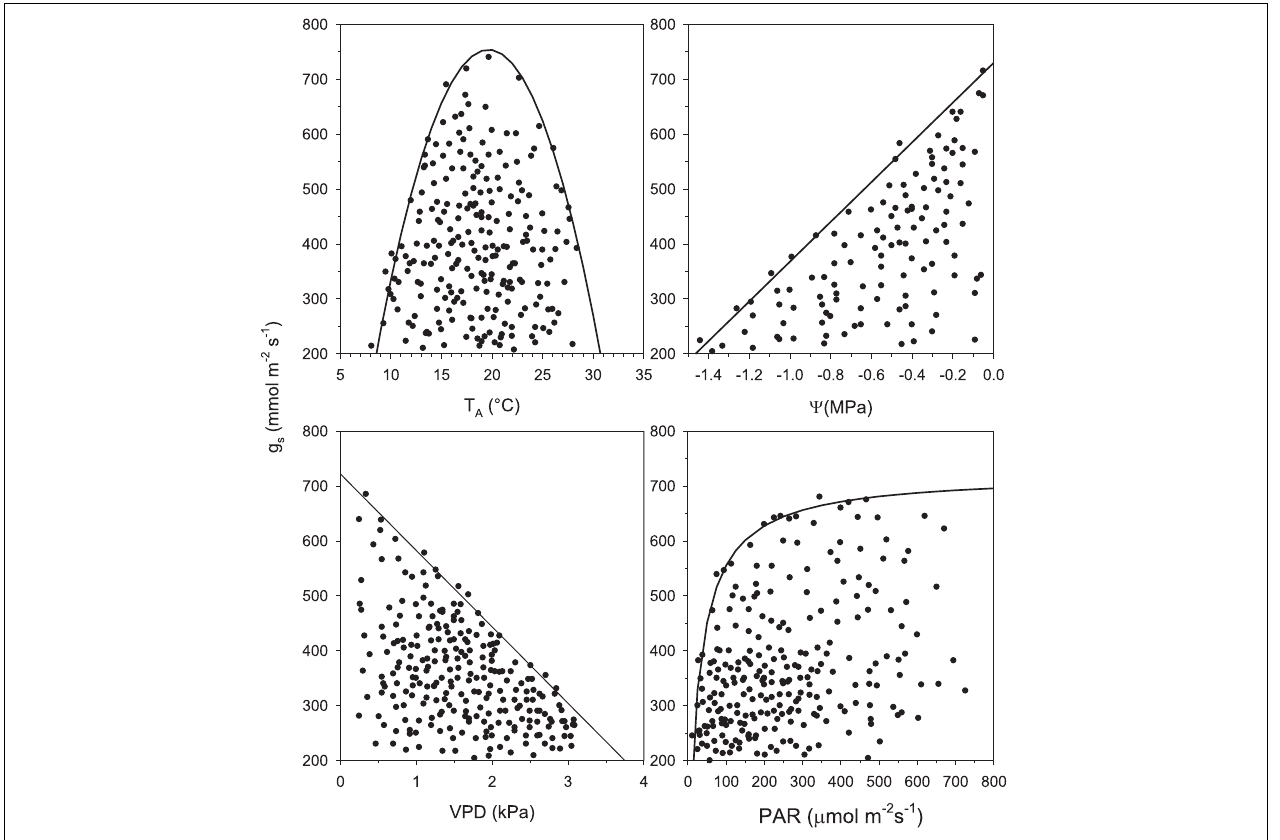
FIGURE 2 | Scatter diagrams and probable boundary-line function of stomatal conductance (g S ) vs. air temperature (T A ), leaf water potential ( ψ ), vapor pressure deficit ( VPD ), and photosynthetically active radiation ( PAR ) for Acacia longifolia .